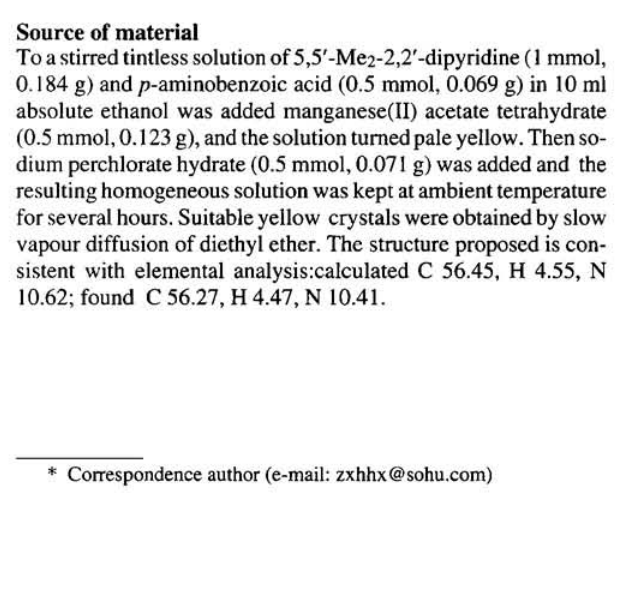
Table 1. Data collection and handling.